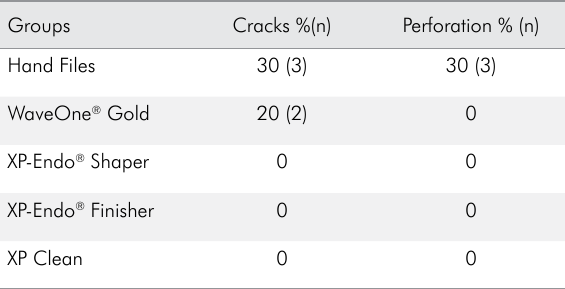
Table 3. Distribution of specimens, showing cracks and perforations after instrumentation, among the experimental groups.